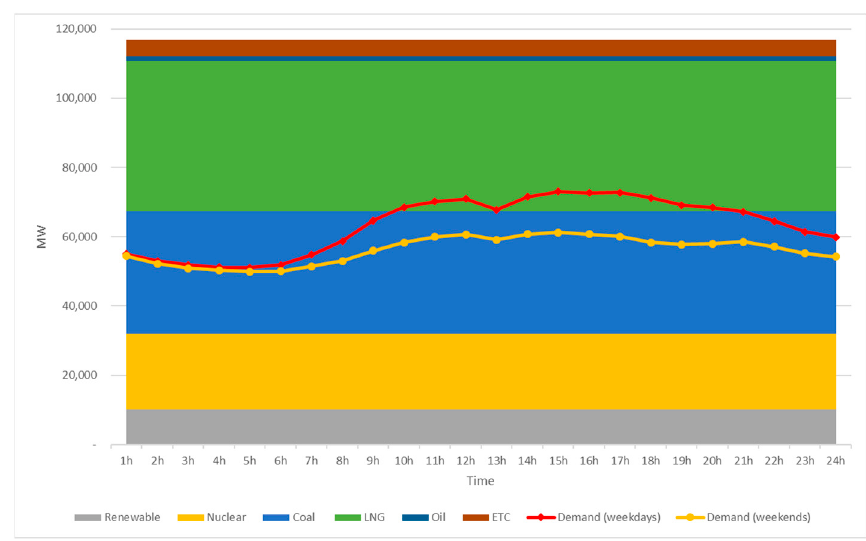
Figure 5. Hourly load profile of weekdays and weekends, and generation mix, in 2014. Table 5. Marginal plant probability profile of coal generators, 2019–2028.